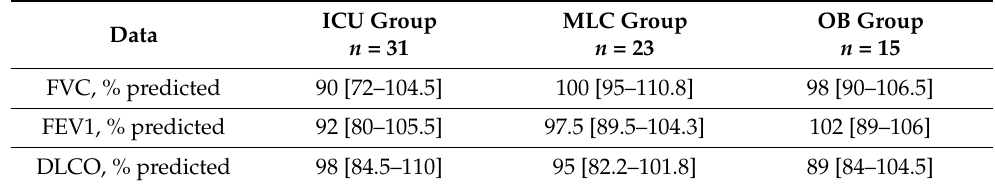
Table 2. Pre-CPET spirometry in the three groups of